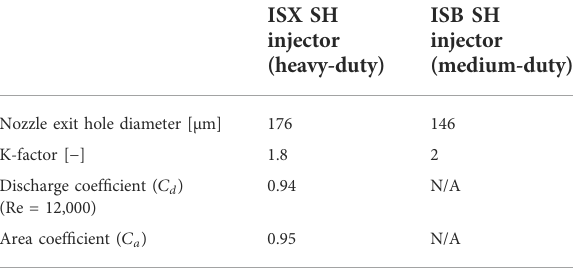
TABLE 6Injector speci fi cation oftheheavy- andmedium-duty single- hole